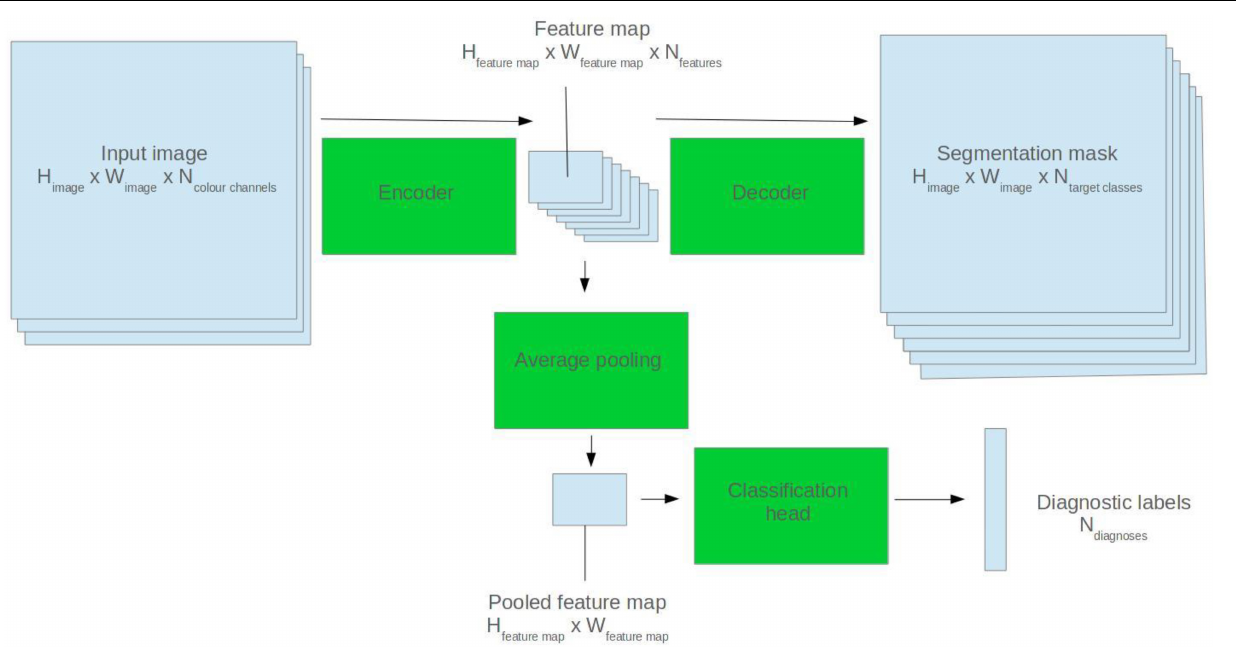
FIGURE 1 | Illustration of how a 2D U-Net model can be applied to segmentation and classification